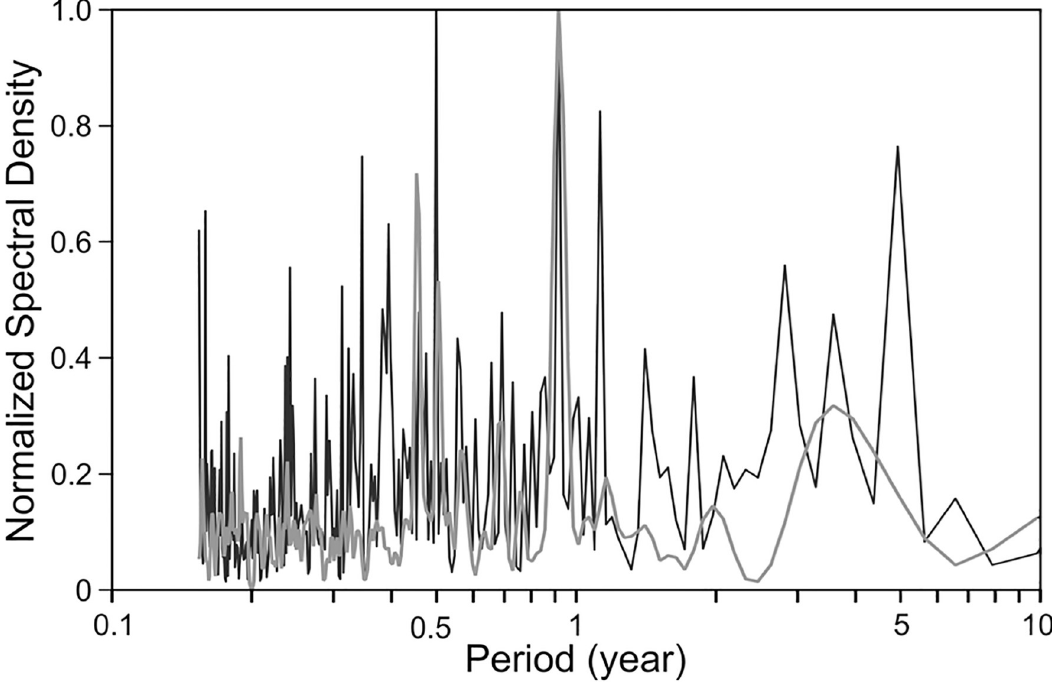
Fig 4. Normalized MEM (gray line) and FFT (black line) spectra of time series days of discolorations (1979–2014). https://doi.org/10.1371/journal.pone.0210631.g004 which shows a very clear upward trend (Fig 8). The number of events remains more or less the same, while the number of dd is increasing. Temporal distribution of forming species blooms Of 23 bloom-forming species recorded from the bay (Table 2), six are toxic: Gymnodinium catenatum (Paralytic Shellfish Poisoning), Pseudo-nitzschia pseudodelicatissima (Amnesic Shellfish Poisoning), Chattonella marina , C . ovata , Margalefidinium polykrikoides and Table 1. Discoloration days (dd) in Mazatlan Bay and number of observed events